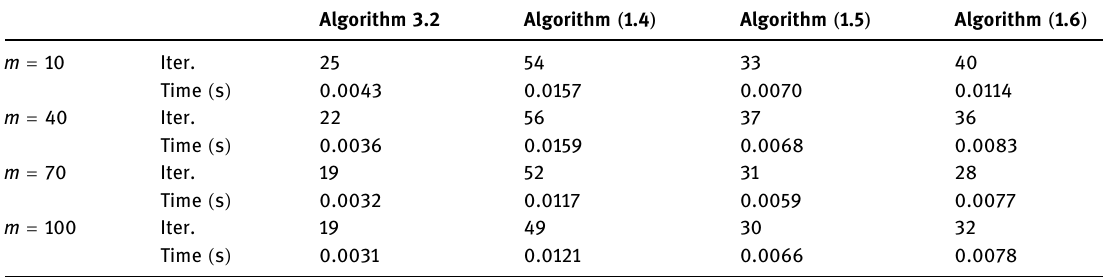
Table 2: Computation result for Example